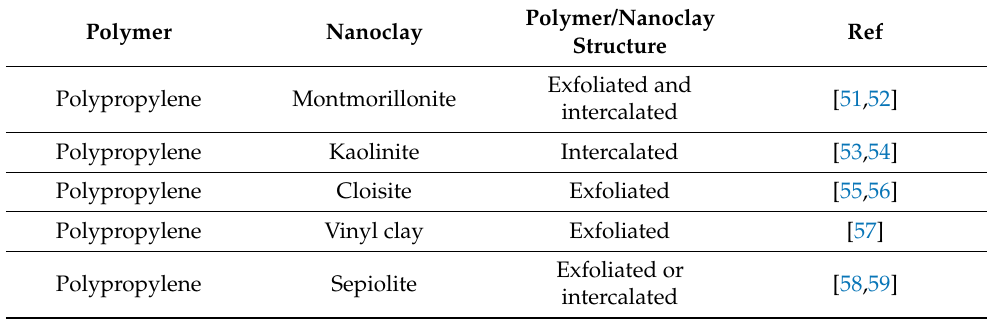
Table 2. Polypropylene/nanoclay nanocomposite prepared by melt blending method.